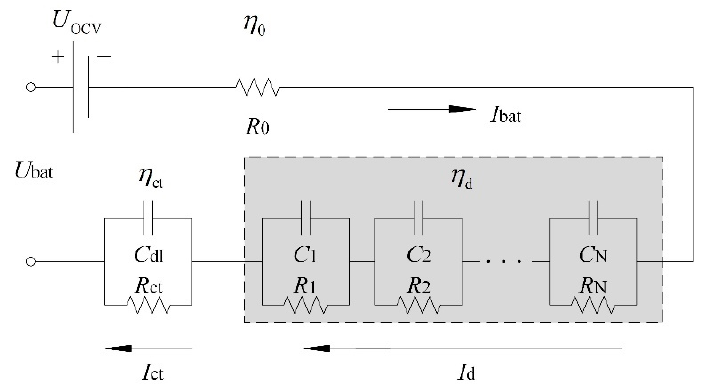
Figure 1. Schematic diagram of N-order Electrical Circuit Model (ECM).